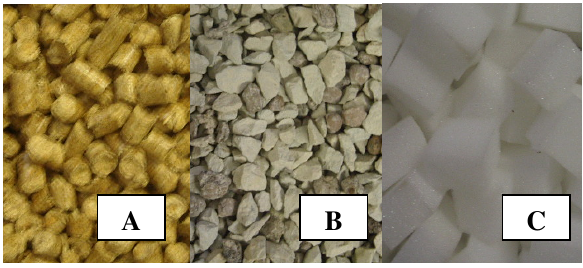
Fig 2. Biocharge of the biofilter: A – wood in chips,